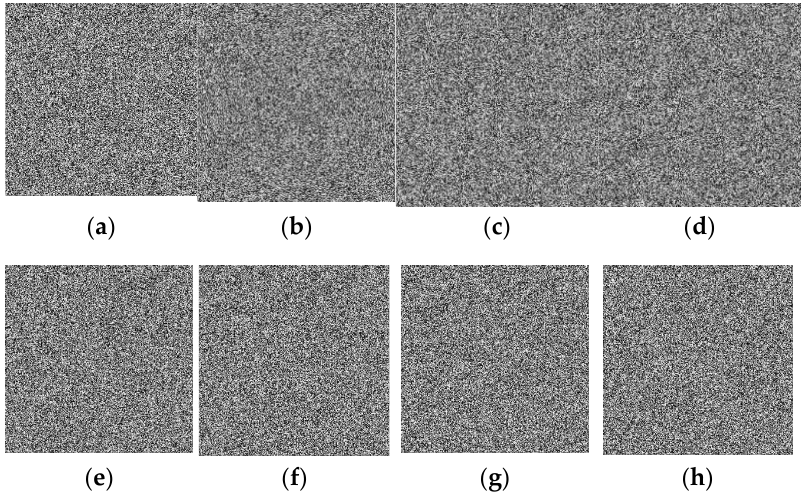
Figure 6. Encrypted images: ( a ) Lena; ( b ) baboon; ( c ) bridge; ( d ) cameraman; ( e ) airplane; ( f ) clock; ( g ) moon; ( h ) ship.